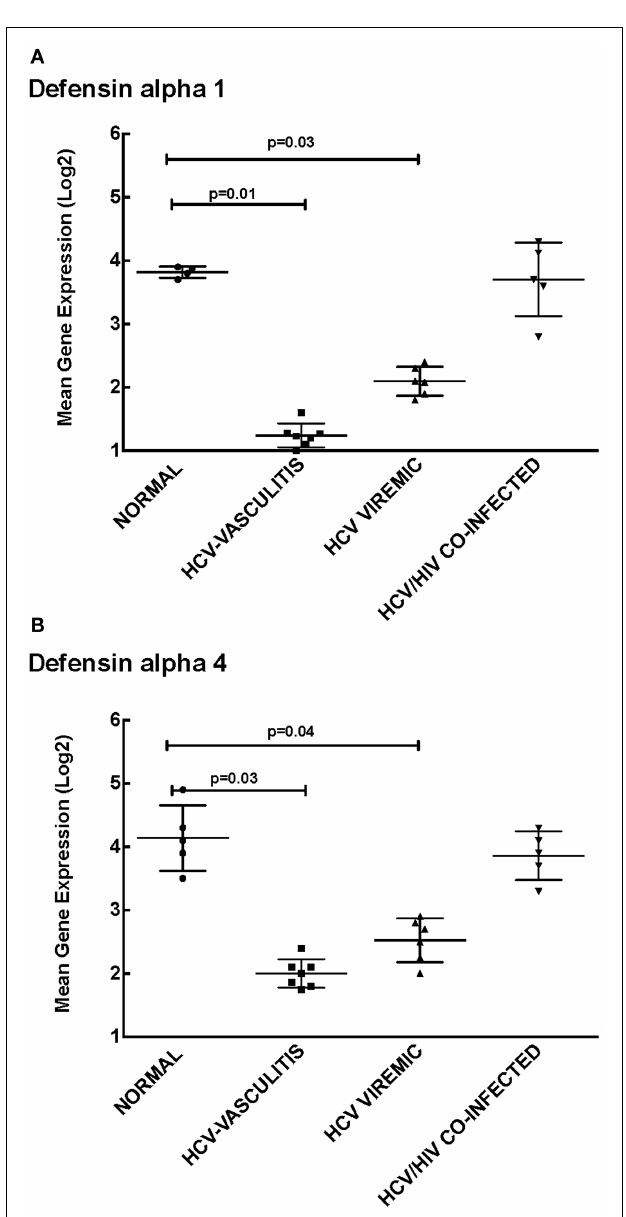
FIGURE 2 |Validation of Cluster 1 microarray data by qPCR analysis . DNA microarray expression of biologically relevant genes selected from Cluster 1 was validated using qRT-PCR as described in the Section “Materials and Methods.” Levels of mean gene expression were calculated in comparison to the expression of GAPDH .The expression of defensin alpha-1 (A) and defensin alpha-4 (B) were lower in the HCV monoinfected ( p = 0.03 and 0.04 with normal, respectively) and HCV MC vasculitis cohorts ( p = 0.01 and 0.03 with normal, respectively).